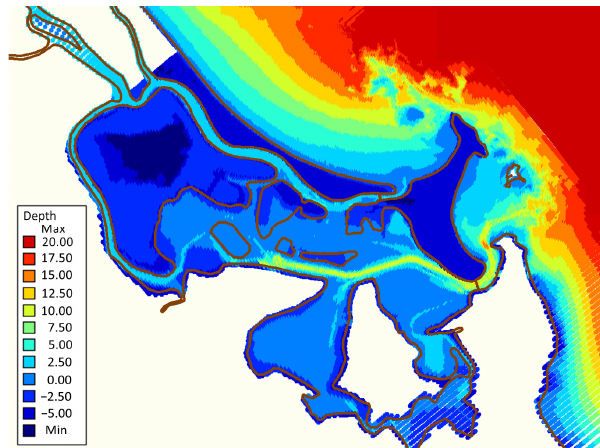
Figure 4. Bathymetry of Cua Lo estuary and its adjacent area in 2019.